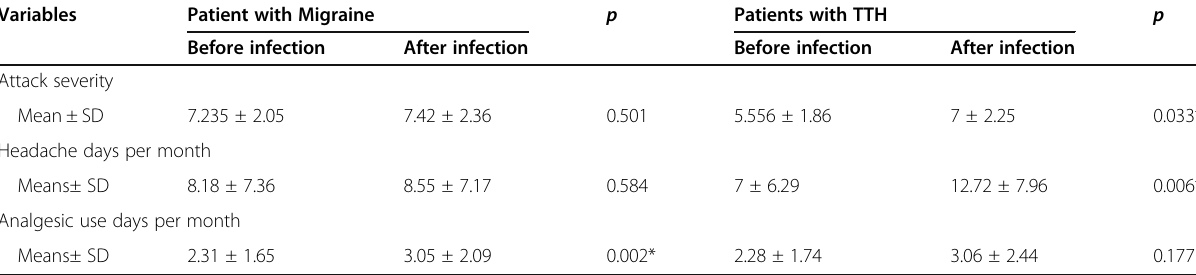
Table 2 Impact of COVID-19 of preexisting headache Variables